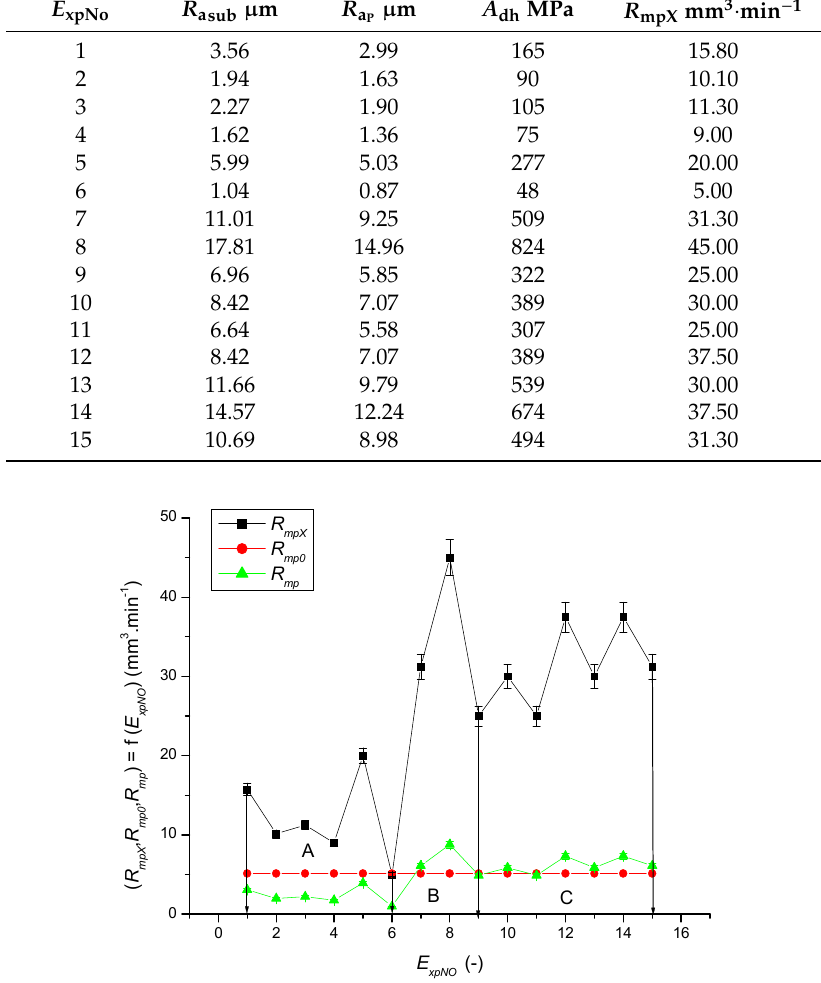
Figure 11. Roughness R a of EN 100 60 substrate and spraying NiCrBSi alloy according to R mp for E xpNO . The surface roughness parameter R a is a significant parameter for us and is also frequently used in our application calculations and in our newly derived relations. The importance of R a roughness for application calculations is elaborated in great detail in our patent specifications [29,30]. This article deals, for example, with the calculation of adhesion A dh (14), with the applied calculation of roughness R aP = f ( R mp , v c , f z , a p ) (10), as well as with the calculation of surface stresses σ rz = f ( R a , R a0 , E mat ) (19). Equation (19) declares a new relation to the Vickers hardness HV = f ( R a , σ rz ), which has been compared and verified with the literature [29,30], as presented in Section 3. The new relations mentioned above describing the relationships between technological, textural, stress-strain parameters and optimal parameters characterizing the milling technology ( a p , f z , v c ) are based on the newly introduced parameter R mp , which is applied in various modifications, namely in relations (8) to (11), (13) and (21). Using this relative technological parameter R mp , it was also possible to reclassify the adhesive sections (Figure 10). 5. Summary The aim of the presented publication was to predict and classify the technological parameters of milling a spherical substrate of steel EN 10060 after HVOF spraying of NiCrBSi nickel alloy, especially in connection with the prediction of adhesive stress between the substrate and the coating.